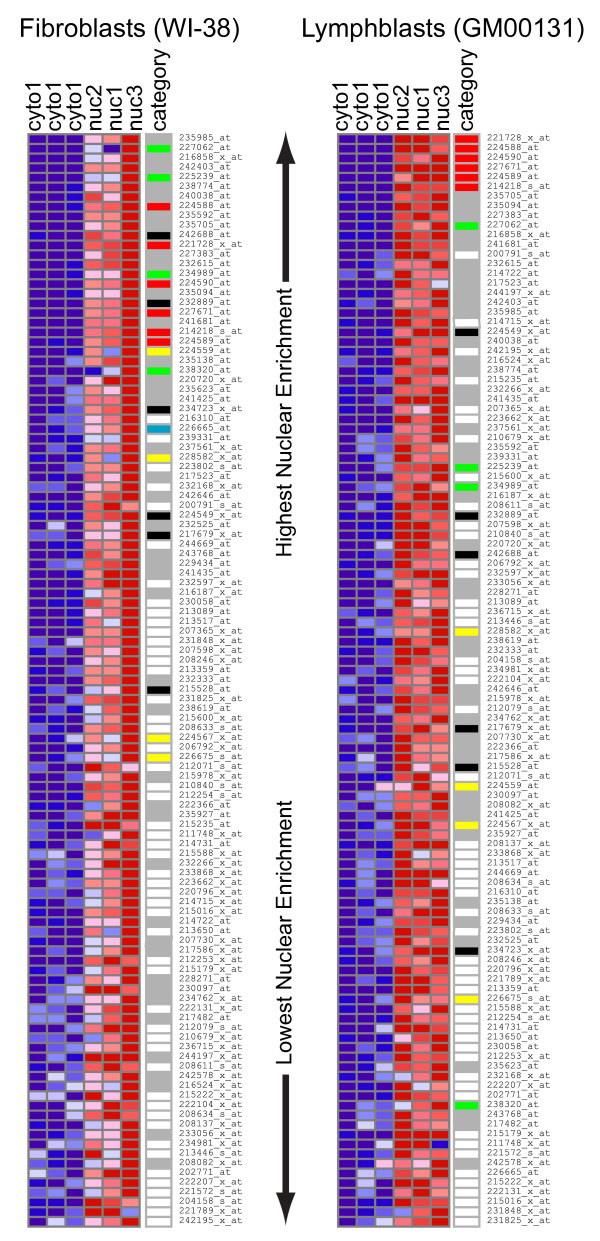
Nuclear Enriched Probe Sets in Lymphoblasts and Fibroblasts. Representative microarray hybridization of the 113 probe sets expressed above threshold that were more than 2 fold enriched in nuclear fraction samples (nuc1, nuc2 and nuc3) versus cytoplasmic fraction samples (cyto1, cyto2 and cyto3) on average in both fibroblasts (WI-38) and EBV-transformed lymphoblasts (GM00131). Probe sets are ranked in descending order of nuclear fraction enrichment from top to bottom. Probe expression is row normalized to show high expression as red and low expression as blue. Nuclear enriched probes were qualified into separate transcript type categories using the University of California at Santa Cruz genome browser and represented graphically beside the representative microarray hybridization. Probes to introns are represented in grey, protein coding transcripts (ORF containing) in white, the XIST locus in red, the NEAT1 locus in green and the NEAT2 locus in yellow.